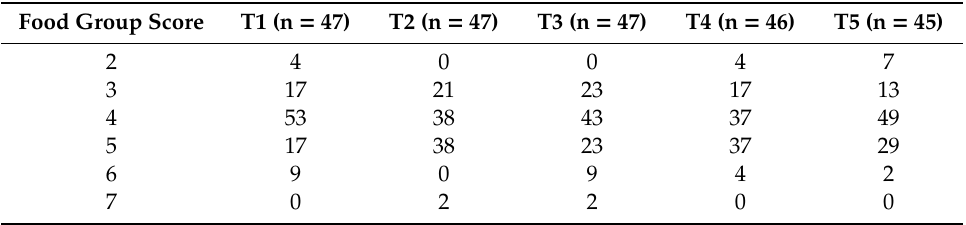
Table 3. The frequency (%) distribution of the food group diversity score at each time